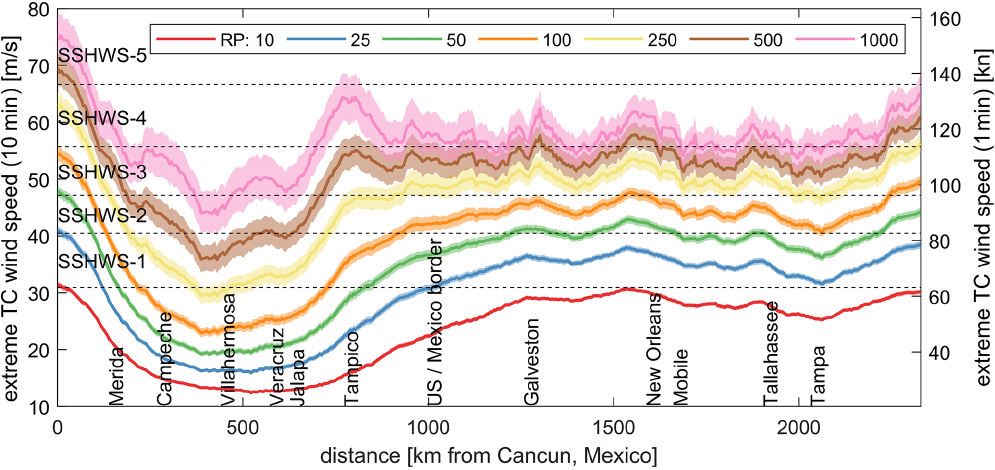
Figure 13. TCWiSE 10-, 25-, 50-, 100-, 250-, 500- and 1000-year return value estimates of wind speed. All wind speeds are in meters per second, 10min averaged and determined at a 10m height (left axis) or 1min averaged in knots (right axis). Cities on the x axis are also depicted in Fig. 12 as black circles. Milepost is presented in the same figure as a white line. Shading shows the 5–95% confidence interval. SSHWS value indicates the corresponding Saffir–Simpson hurricane wind